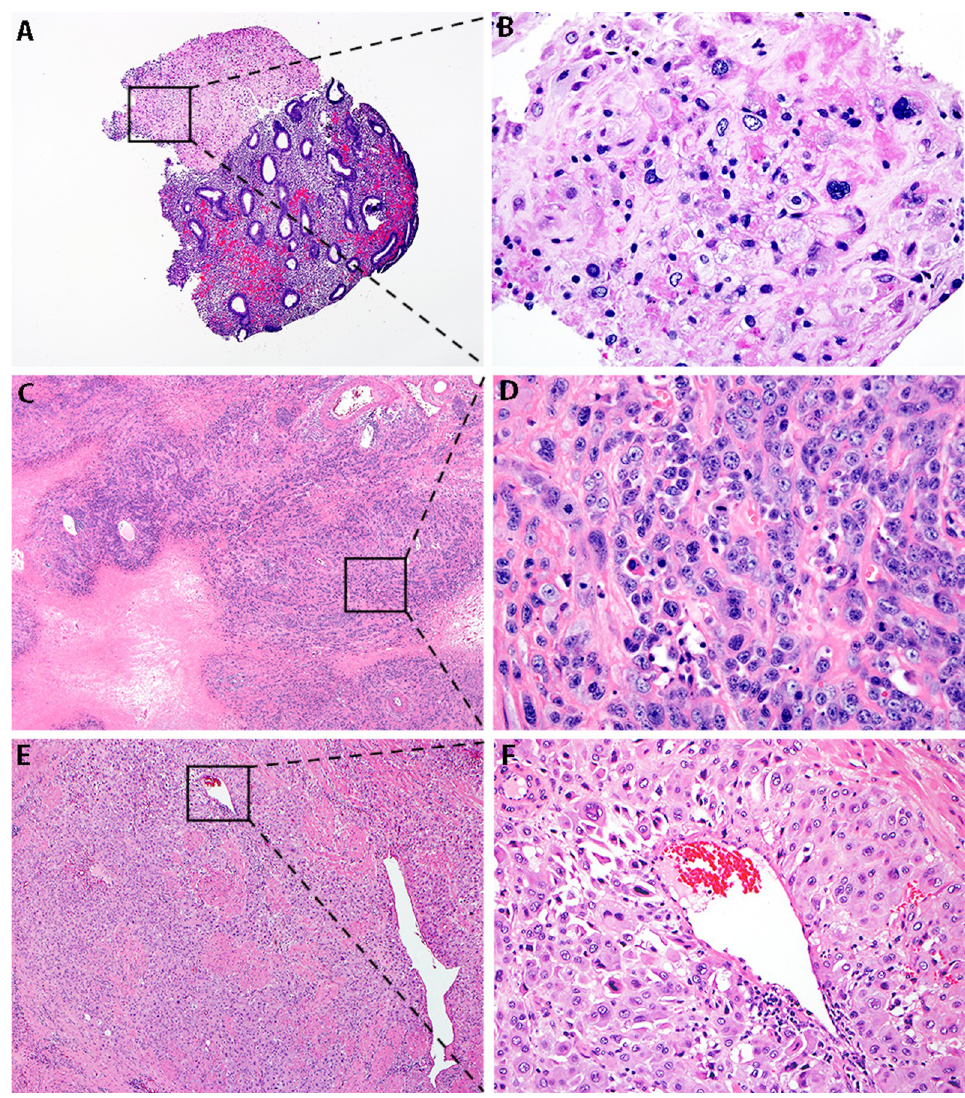
Fig 1. Representative histologic images. Magnification 40x (A, C, E) and 200x (B, D, F). (A, B) Placental site nodule. Well-circumscribed nodular lesion composed of chorionic-type intermediate trophoblast with abundant clear to eosinophilic cytoplasm and round nuclei, embedded in a hyalinized matrix. (C) Epithelioid trophoblastic tumor. Large expansile nests and nodules, separated by eosinophilic hyaline-like material composed of chorionic-type intermediate trophoblast. The trophoblast have a moderate amount of clear to eosinophilic cytoplasm and relatively uniform round nuclei with small nucleoli and multiple mitotic figures (D). (E, F) Placental site trophoblastic tumor. Infiltration of myometrium by sheets of implantation site-type intermediate trophoblast composed of large cells with abundant eosinophilic to amphophilic cytoplasm with pleomorphic nuclei, some of which are seen in association with the wall of a blood